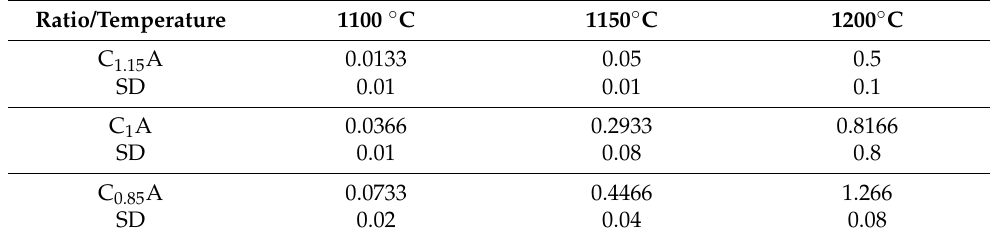
Table 4. Breaking load of different sintering temperature with different pellets composition. (All measurements in kN, SD: standard